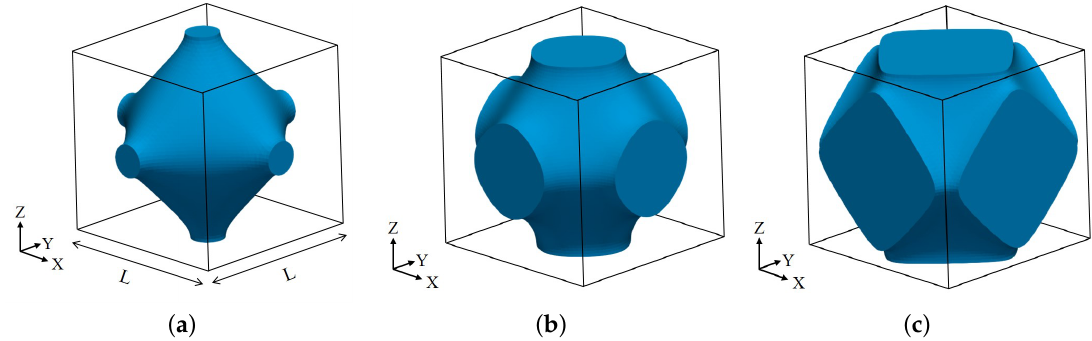
Figure 1. Geometry of Schwarz primitive cells. ( a ) Isovalue t = − 0.87 and relative density ρ = 0.25; ( b ) isovalue t = 0 and relative density ρ = 0.50; and ( c ) isovalue t = 0.87 and relative density ρ =